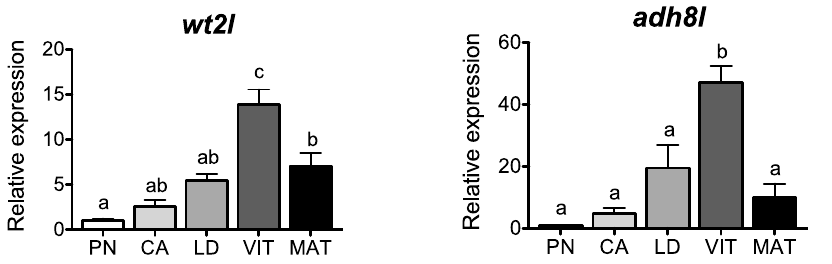
Fig. 8. Expression profiles of genes associated with cell differentiation and growth during major stages of oogenesis in coho salmon. Messenger RNA levels were analyzed by qPCR and data were normalized to the geometric mean of four reference genes ( eef1a , ctsd , ctsz and actb ). PN, perinucleolus stage follicles; CA, cortical alveolus stage follicles; LD, lipid droplet stage follicles; VIT, mid-vitellogenic stage follicles; MAT, postvitellogenic/preovulatory stage follicles. Bars not sharing the same letter are significantly different (P , 0.05; n 5 4 fish/stage for PN-, CA-, LD-, and VIT-stages, n 5 3 fish for MAT-stage, mean ¡